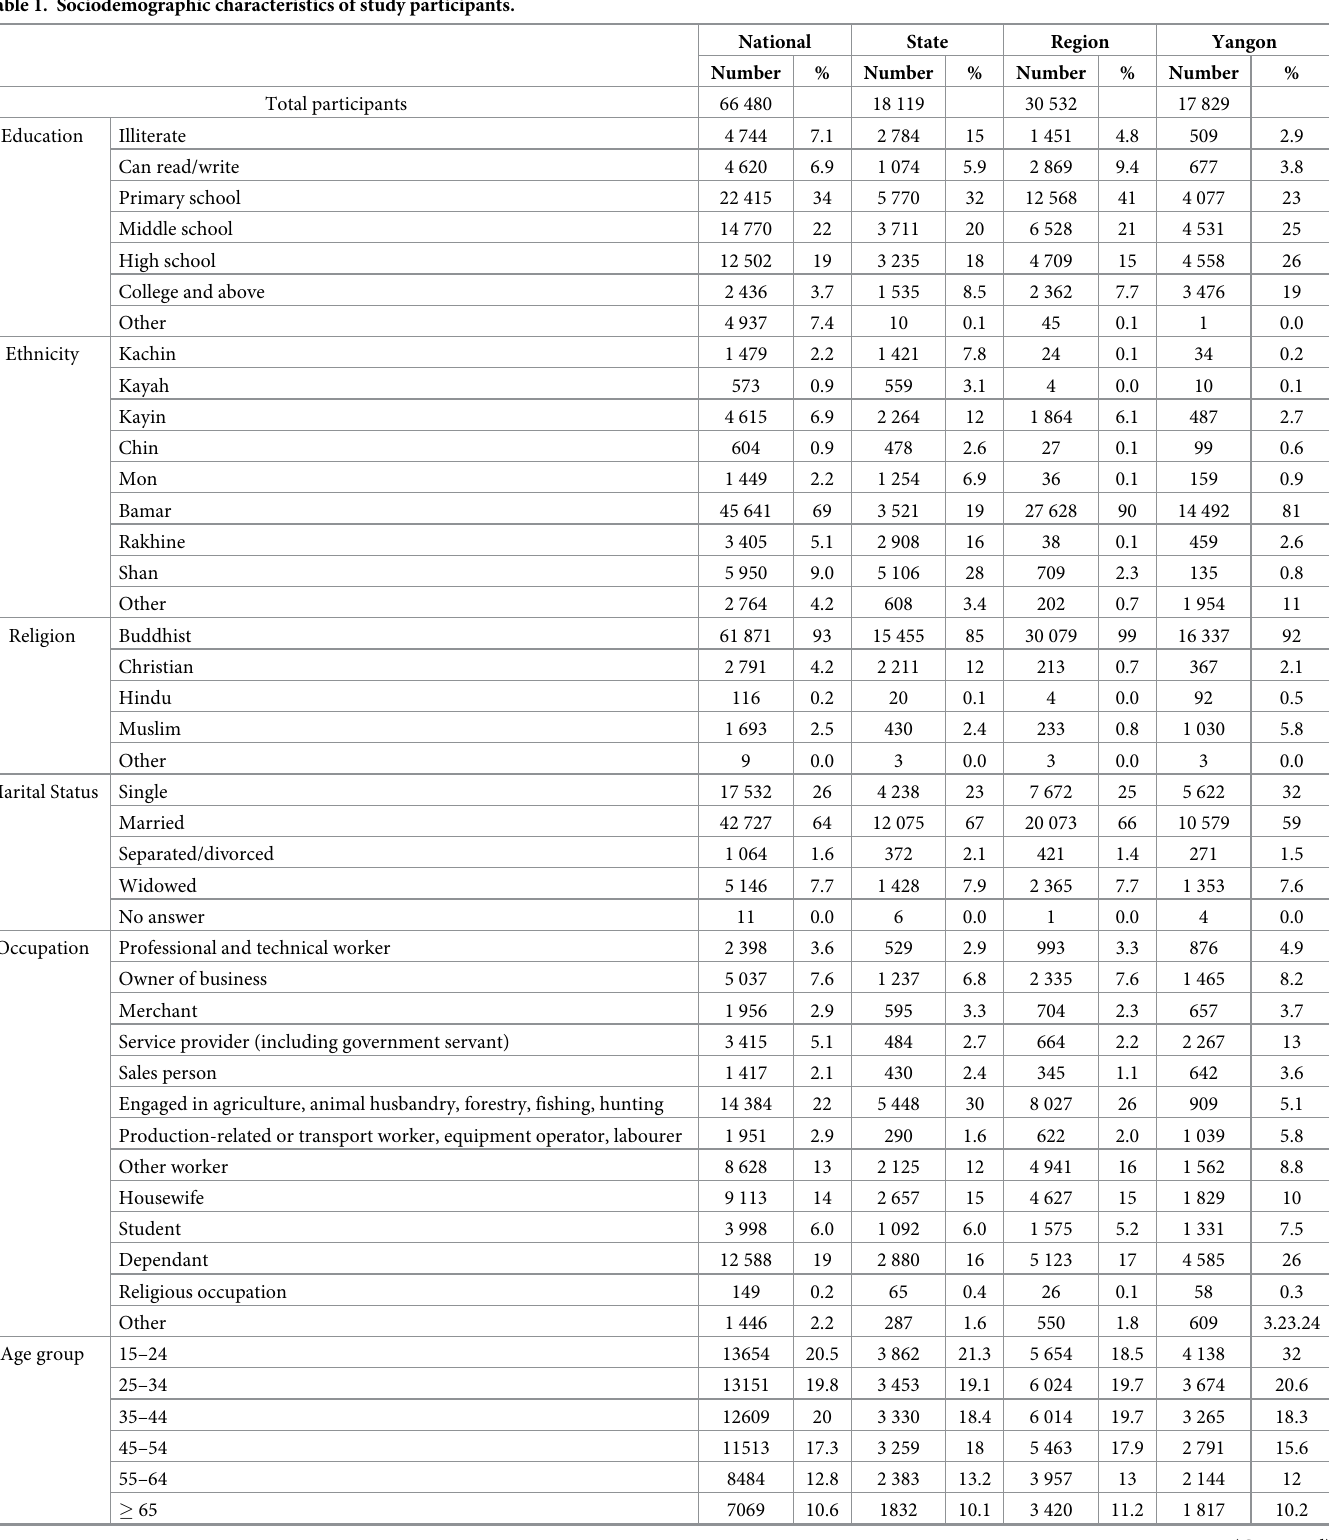
Table 1. Sociodemographic characteristics of study